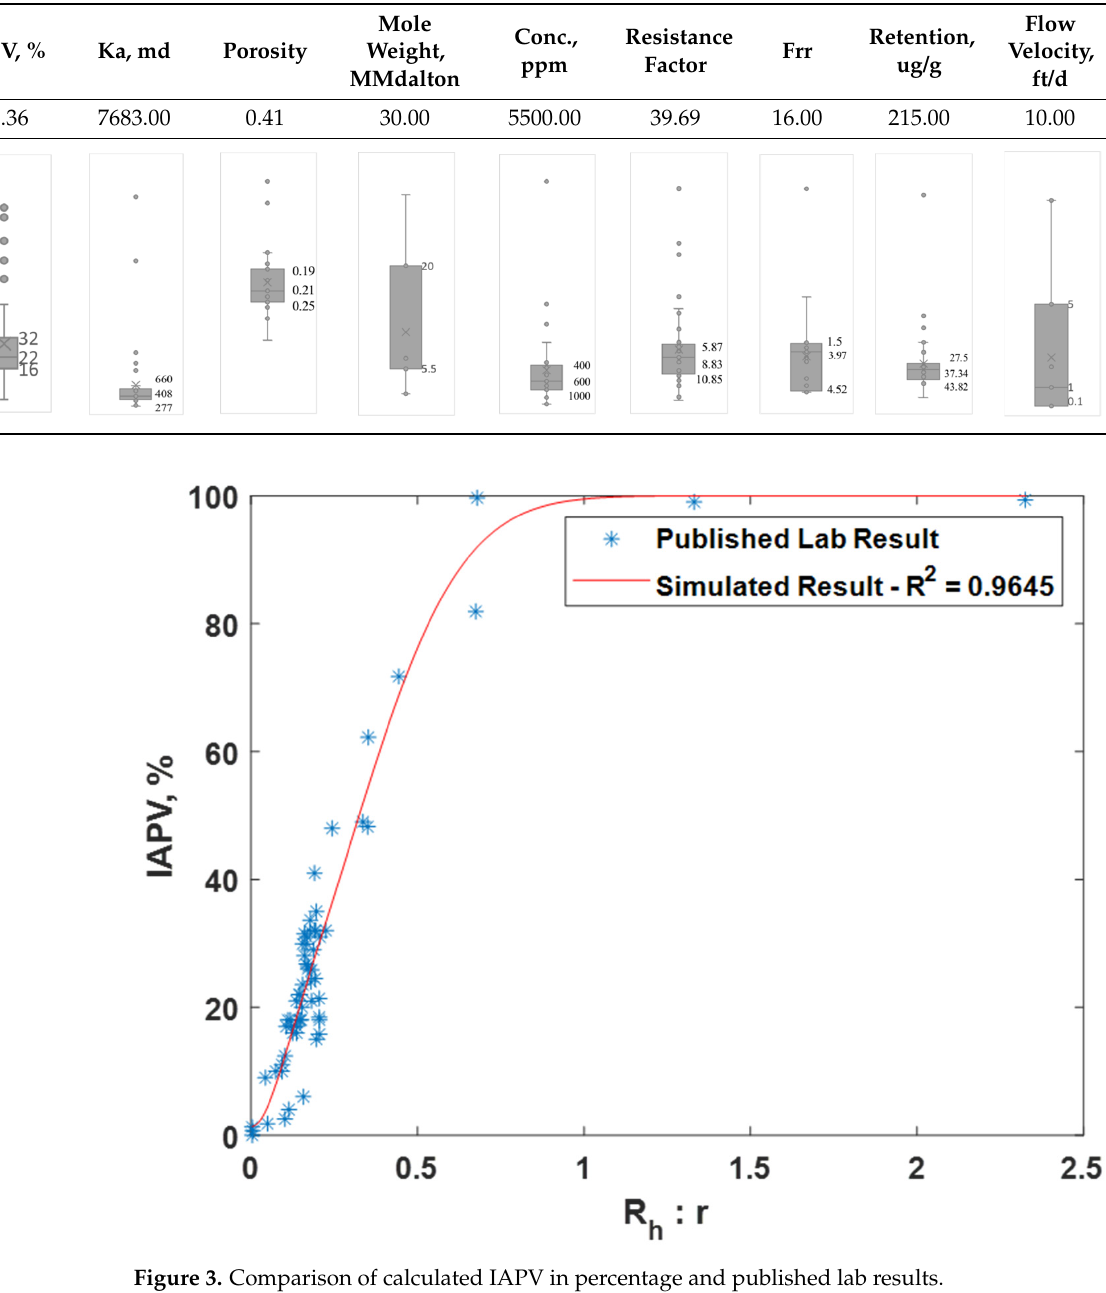
Figure 3. Comparison of calculated IAPV in percentage and published lab results.